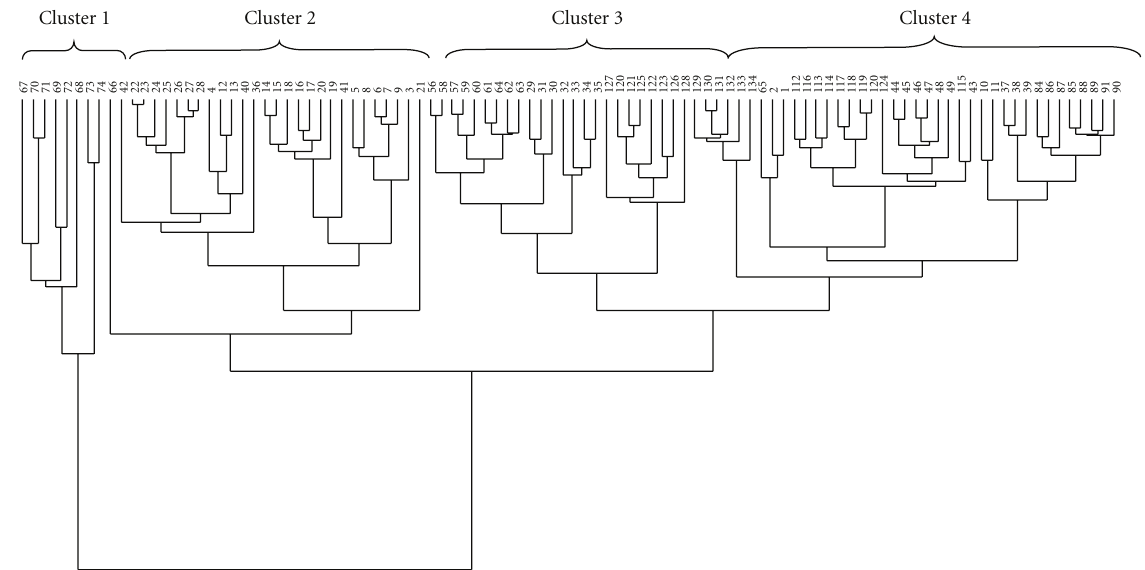
Figure 3: UPGMA cluster of Milicia excelsa individuals from twelve populations. 1–11 (Aplahoue), 12–20 (Lokossa), 21–28 (Save), 29–37 (Sakete), 38–49 (Ketou), 50–62 (Bohicon), 63–80 (Niaouli), 81–92 (Tamarou), 93–102 (Biro), 103–118 (Bassila), 119–126 (Bante), and 127– 134